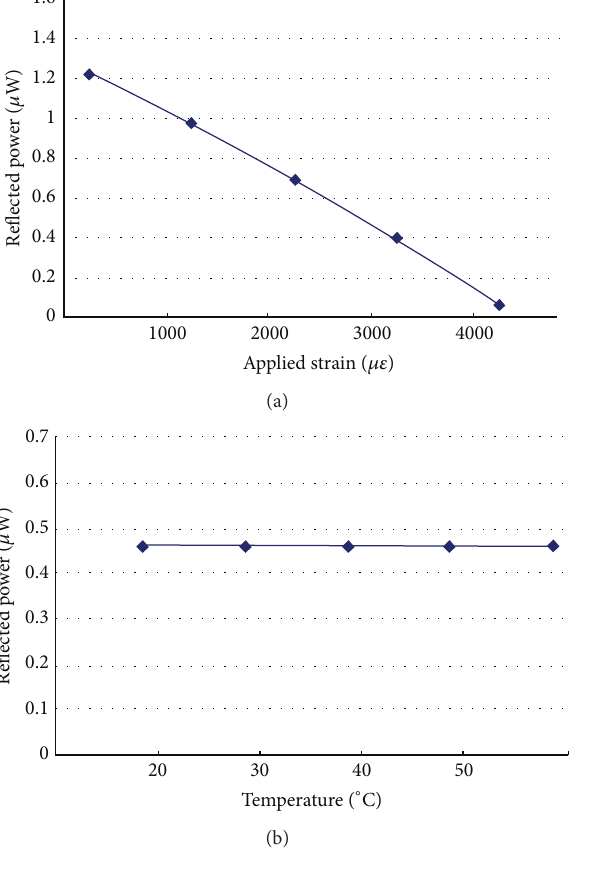
Figure 3: (a) Reflected power against applied strain; (b) reflected power against